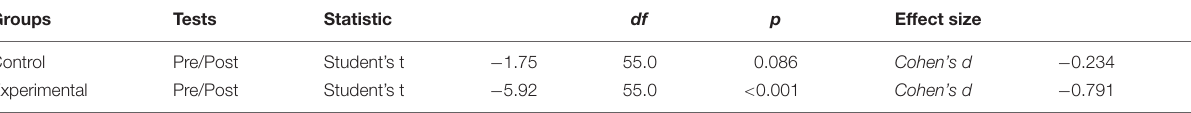
TABLE 8 | A comparison of group achievements using Paired t- test analysis.